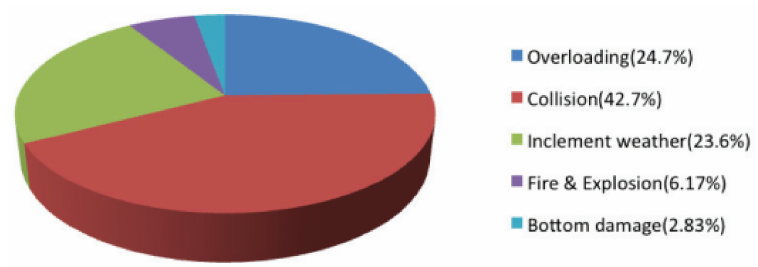
Figure 2. Causes of maritime accidents in Taiwan of 2013–2018 [34].